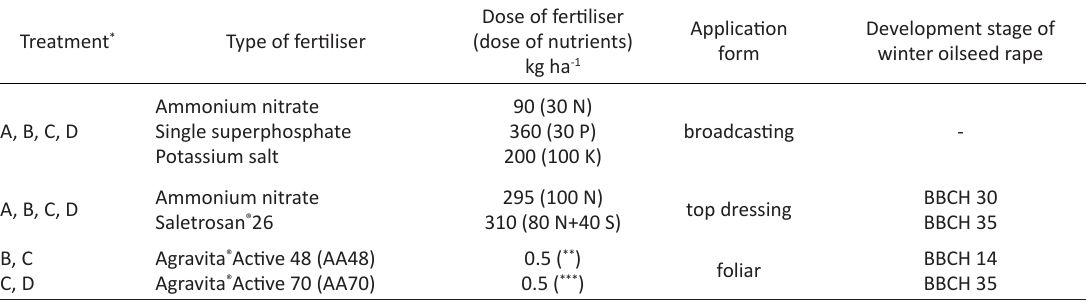
Table 1. Mineral fertilisation regime Treatment * Type of fertiliser